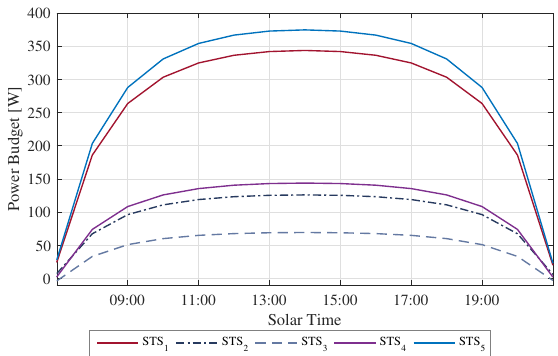
Figure 15. Comparison of the power budget of the five solar trackers.